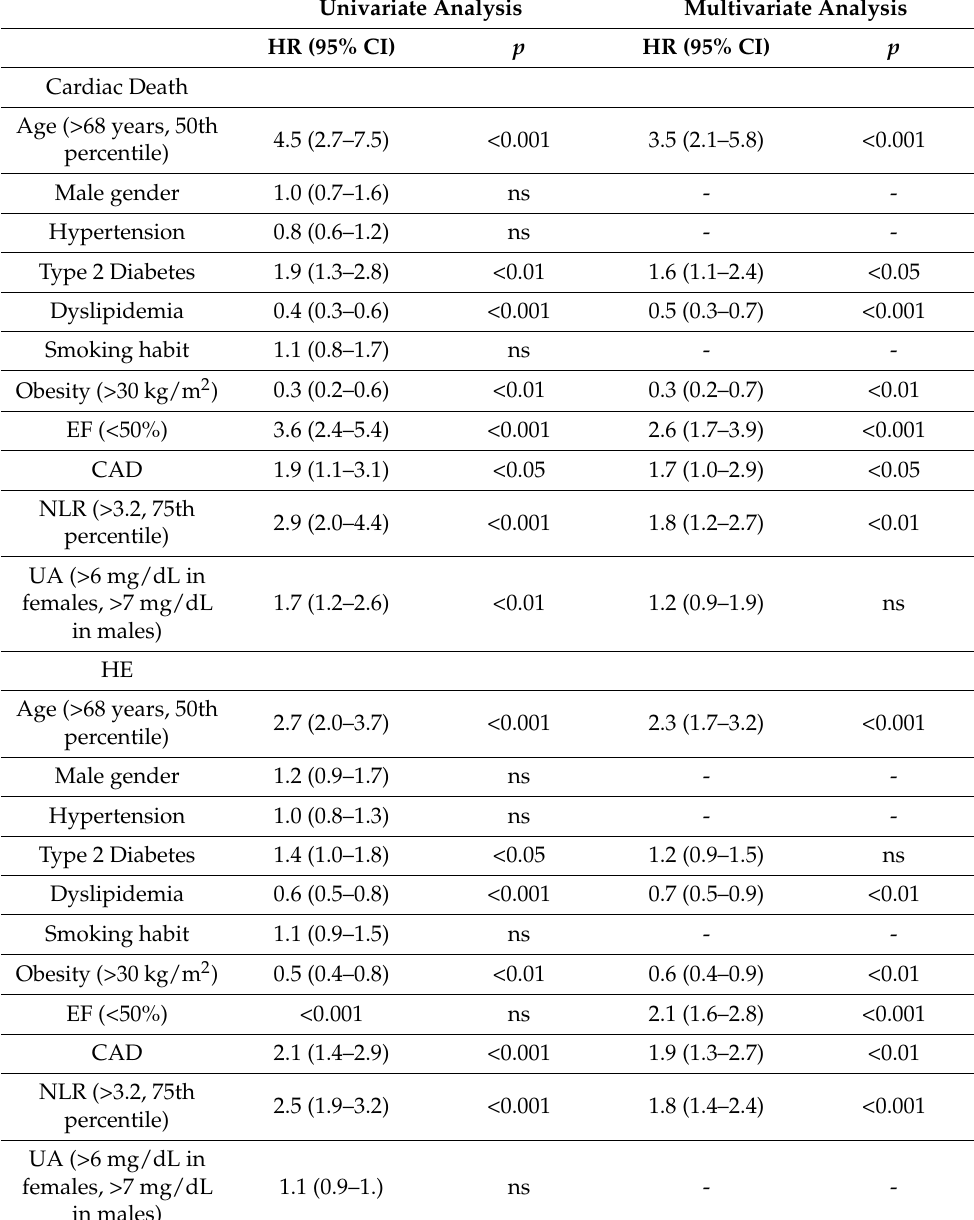
Table 4. Cox predictive model for cardiac death and hard